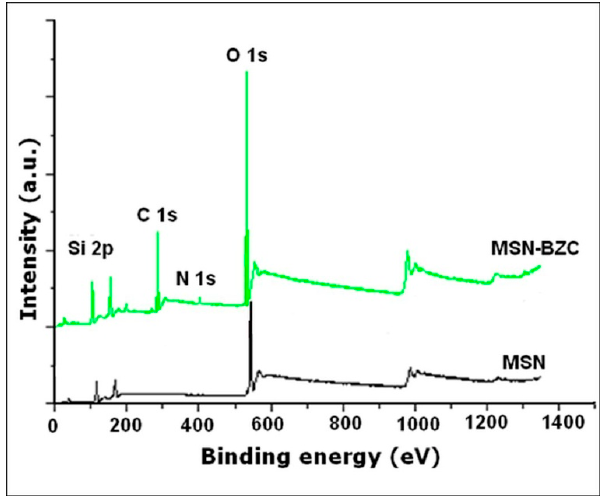
Figure 2. The X ‐ ray photoelectron spectroscopy (XPS) survey spectra for MSN and modified MSN with BZC.